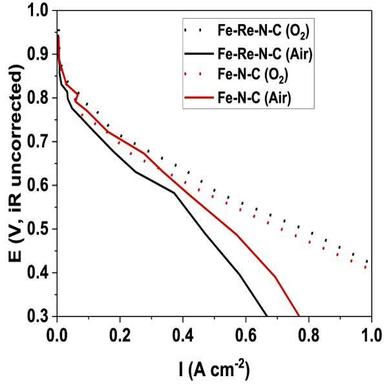
Polarization curves of FeReNC and FeNC catalysts in fuel cell tests with air and O2 feed. Conditions: 5 cm2 active area in a 50 cm2 differential cell. Cathode: 3 mg/cm2 , 55 % Nafion, Membrane: Nafion 211. Anode 0.2 mgPt/cm2 Pt/C. 700/1700 sccm H2/Air (500/1000 sccm H2/O2), 100 % RH, 9 psig.